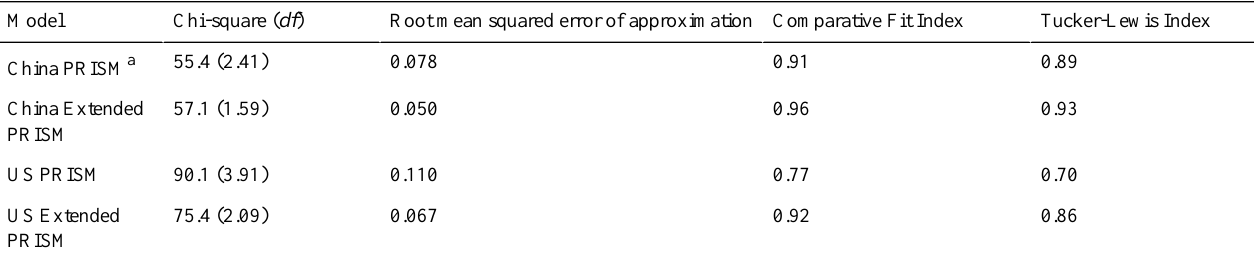
Table 2. Summary of model fit.